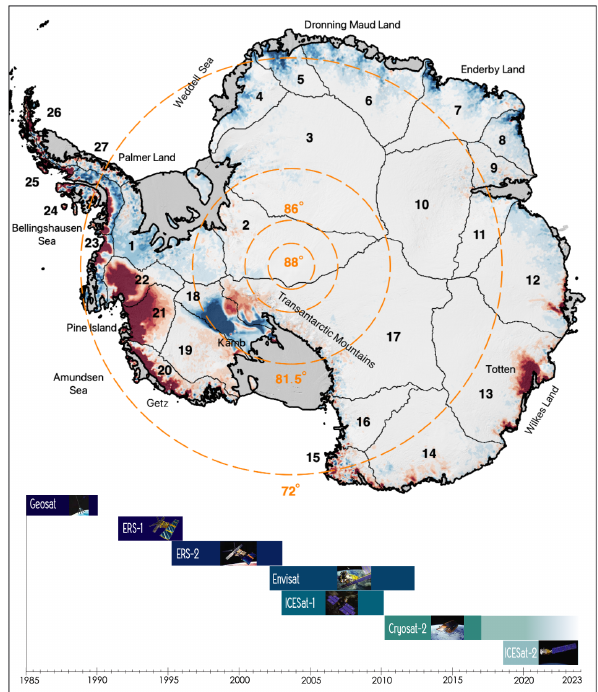
Figure 1. Spatial and temporal coverage of the seven satellite al- timetry missions used to produce the elevation change synthesis. Concentric dashed circles and labels (orange) indicate orbital lim- its of each mission (Geosat 72 ◦ ; ERS-1, ERS-2, and Envisat 81.5 ◦ ; ICESat 86 ◦ ; and CryoSat-2 and ICESat-2 88 ◦ ). Antarctic drainage basins 1–27 are shown in black (Zwally et al., 2012). Orbital limits and drainage basins are plotted over elevation change rates (1992– 2020) from this study, with a range of ± 20cma − 1 (blue indicates positive and red negative changes in